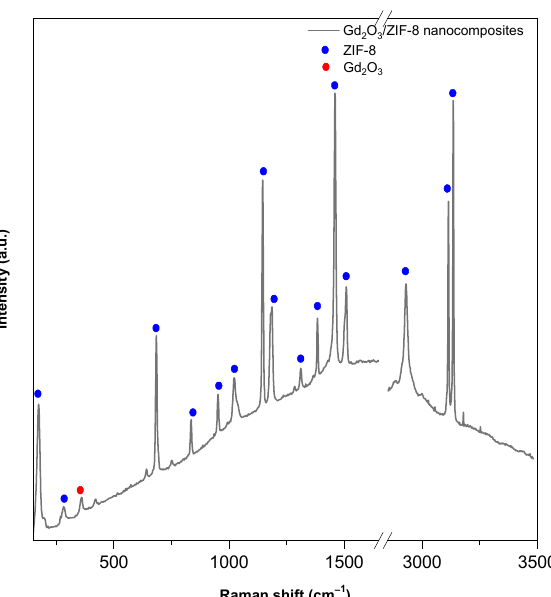
Figure 2. Raman spectra of the synthesized Gd 2 O 3 -ZIF-8 nanocomposites. The major peaks of ZIF-8 were observed at 282 cm − 1 (Zn–N stretching), 684 cm − 1 (imidazolium ring puckering), 825 cm − 1 , 952 cm − 1 , 1032 cm − 1 (C–H bending), 1146 cm − 1 (C–N stretching), 1180 cm − 1 (C–N stretching + N–H wag), 1186 cm − 1 (C–N stretching), 1311 cm − 1 (N–H wag), 1384 cm − 1 (CH 3 bending), 1460 cm − 1 (C–H bending), 1509 cm − 1 (C–C stretching), 2930 cm − 1 (methyl C–H stretching), 3113 cm − 1 , and 3135 cm − 1 (imidazolium ring C–H stretching)